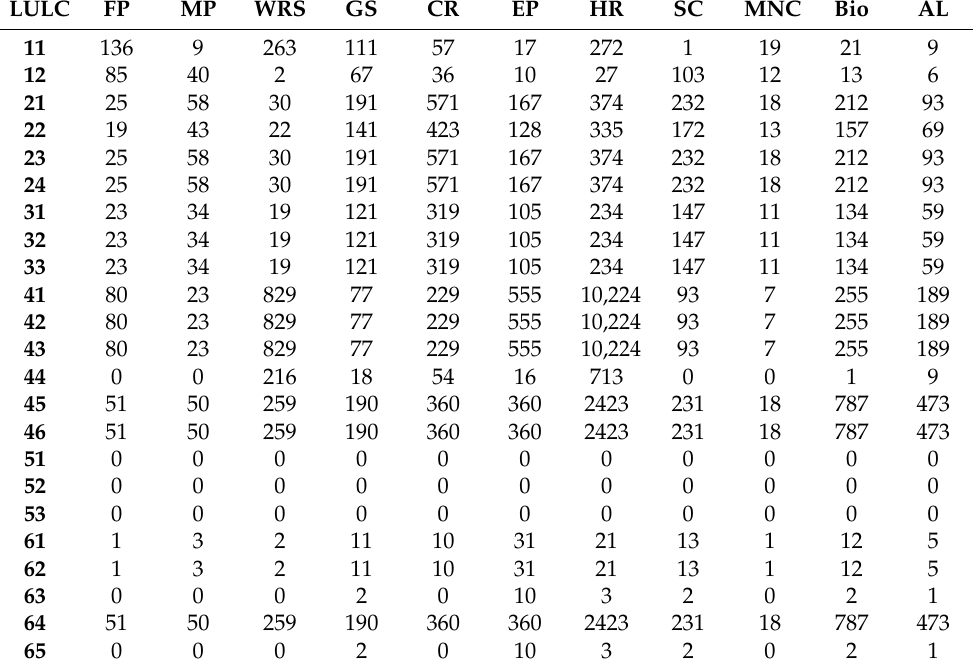
Table 1. Ecosystem services value (ESV) of different land-use and land-cover (LULC) types per unit area (RMB per km 2